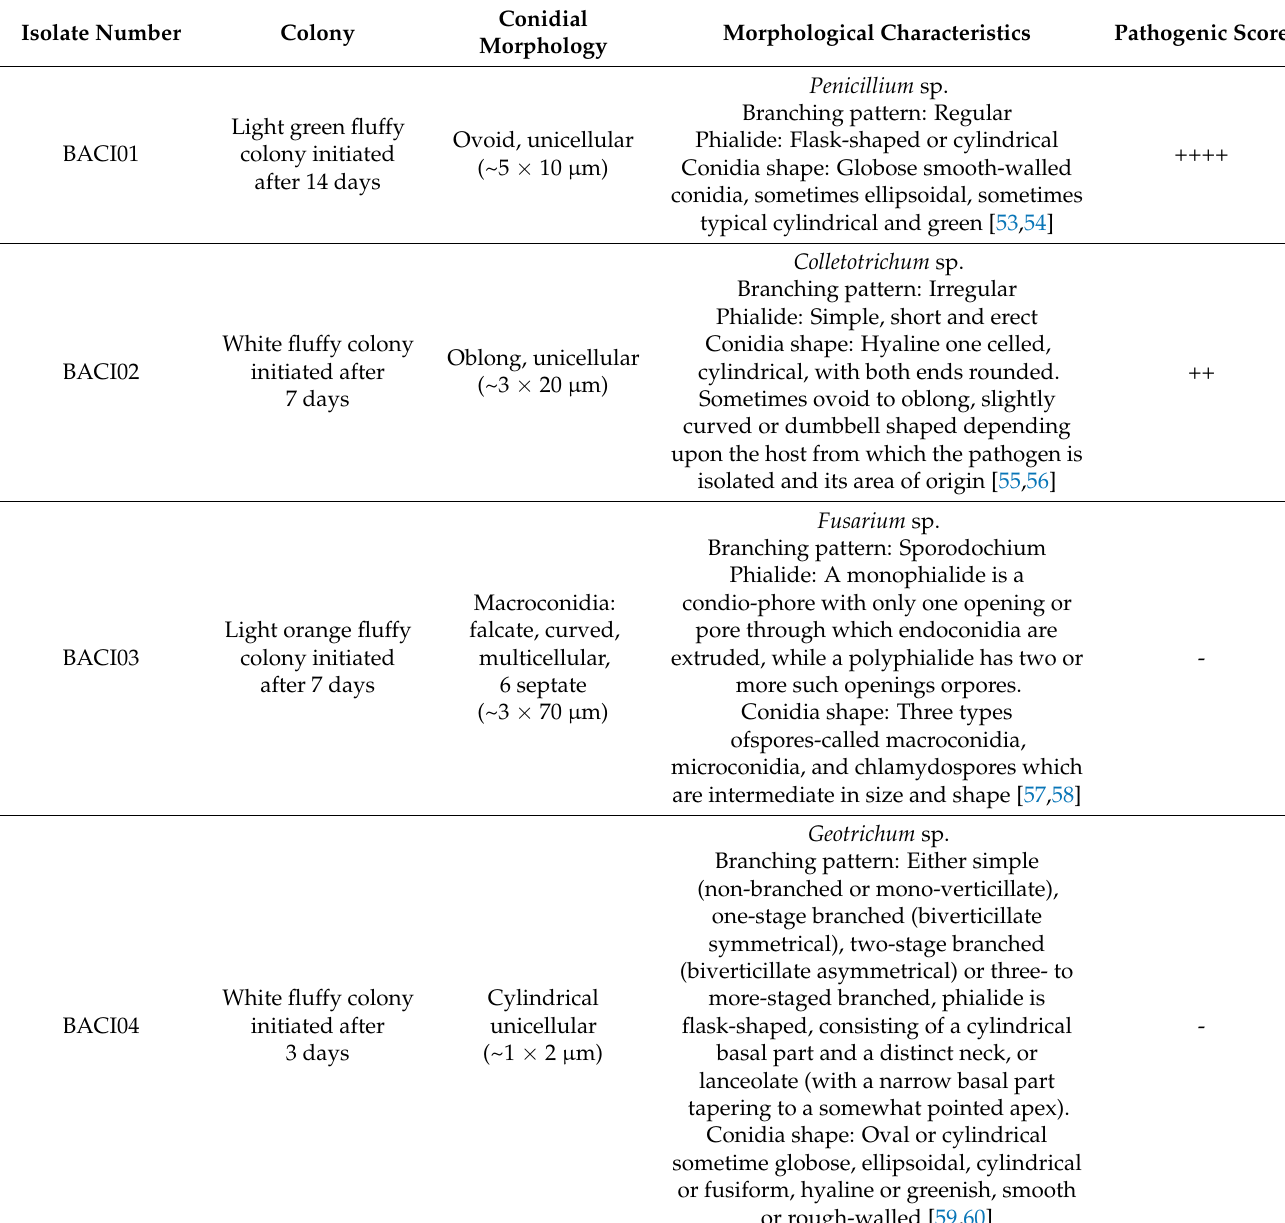
Table 2. Morphology of fungal isolates collected from ‘Sai-Namphaung’ tangerine fruits during